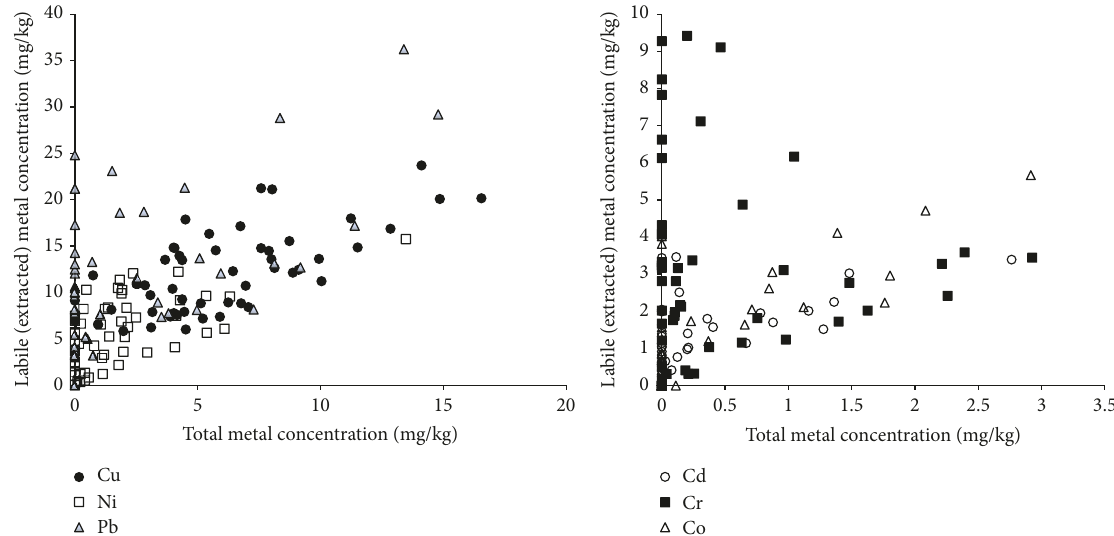
Figure 1: Relationship between Cu, Ni, Pb, Cd, Cr, and Co content of the dried herbal samples and the extracted metal contents of the labile fractions in the infusions.